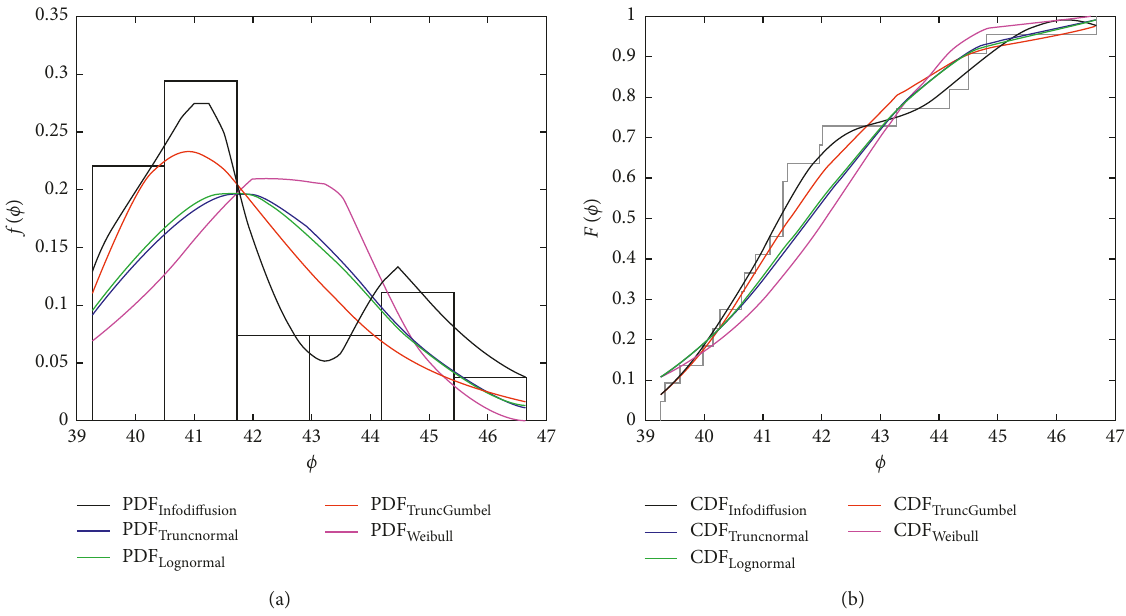
Figure 7: PDFs and CDFs of φ under different marginal distribution